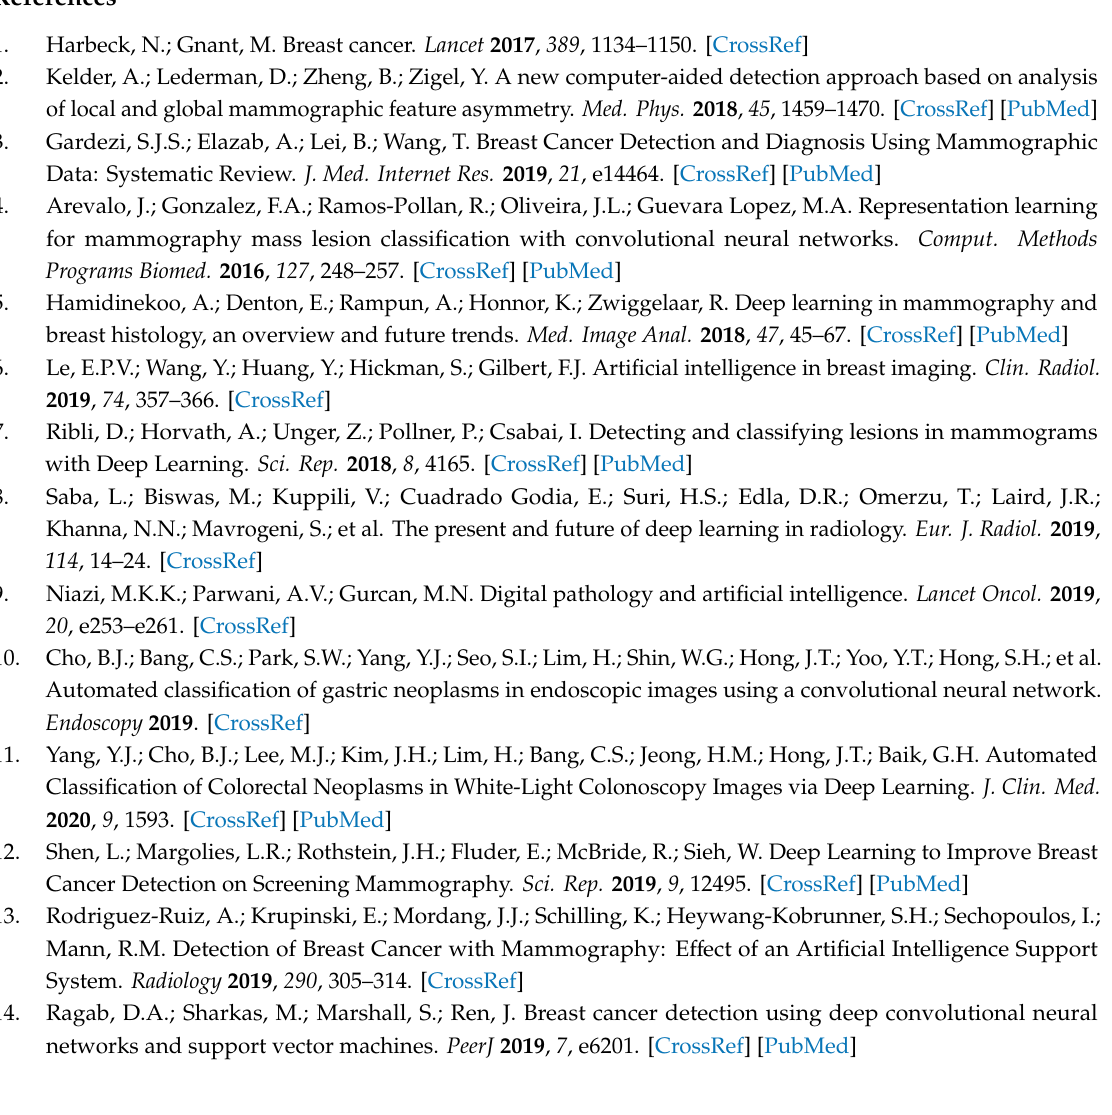
Table S1: Performance for breast cancer detection in mammograms by the DenseNet-169 model using age as a